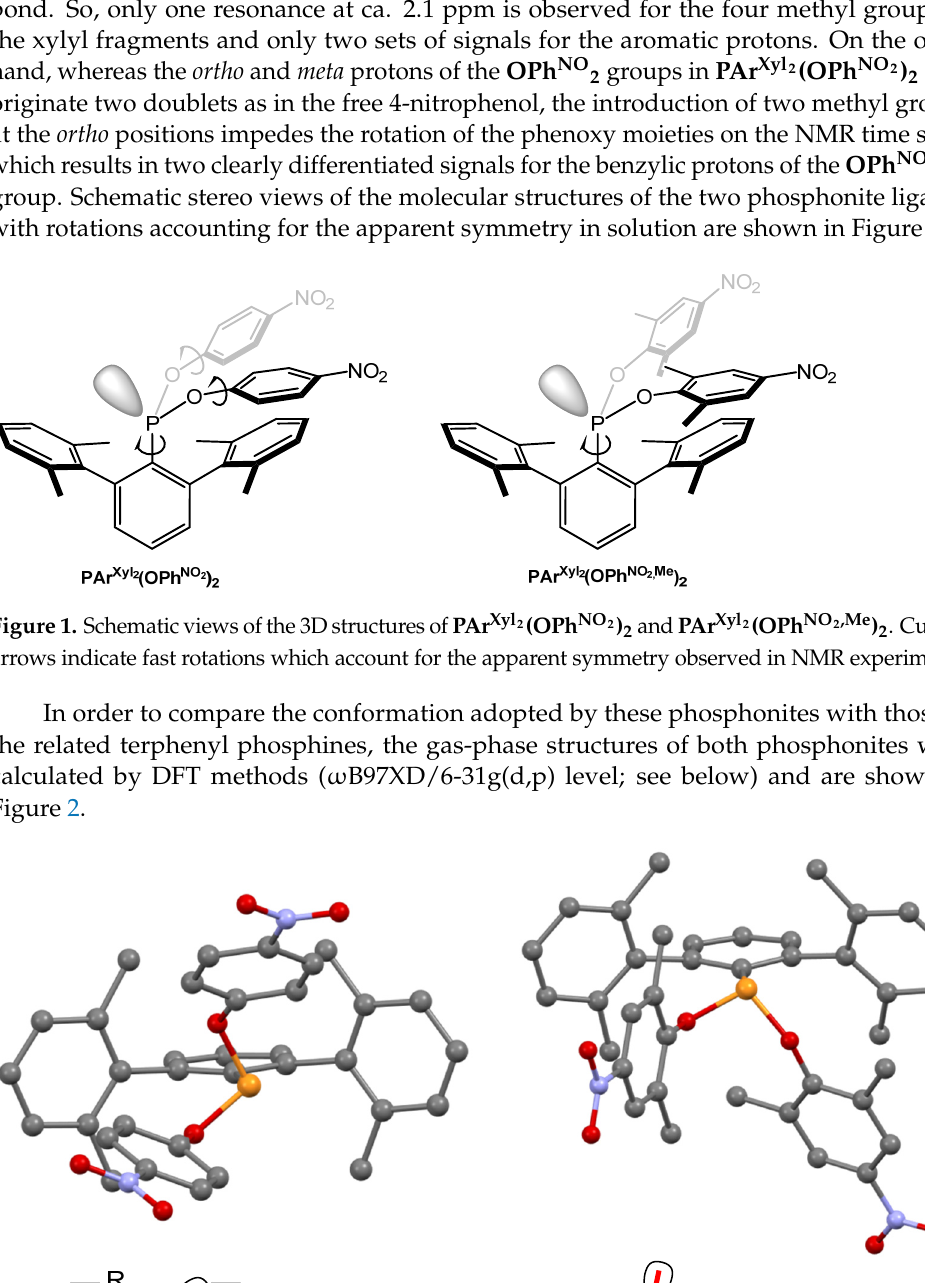
Figure 2. Views of the calculated gas-phase structures of PAr Xyl 2 (OPh NO 2 ) 2 ( left ) and PAr Xyl 2 (OPh NO 2 ,Me ) 2 ( right ) (C: grey; N: purple; O: red; P: orange). Conformations C and A relate to previously reported discussions on terphenyl phosphines ligands [18,19,26]. The two planes defining the dihedral angle are that containing the central ring of the terphenyl group and that containing the P—C bond and the axis of the P lone pair.